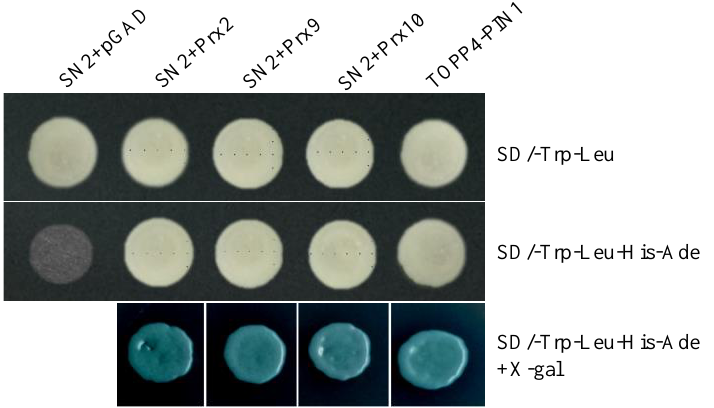
Figure 6. StSN2 physically interacts with peroxidases in a yeast two-hybrid system. The three peroxidases fused to pGADT7 are Prx2 (M1AU65), Prx9 (M1A251) and Prx10 (M1CCJ9). TOPP4, type-one protein phosphatase 4 in Arabidopsis; PIN1, pin-formed1 in Arabidopsis. X-gal, 5-Bromo-4-chloro-3-indolyl-b-D-galactopyranoside acid. The experiments were repeated three times. 2.6. StSN2 Altered H 2 O 2 Content and the Activities of Superoxide Dismutase (SOD) and Catalase